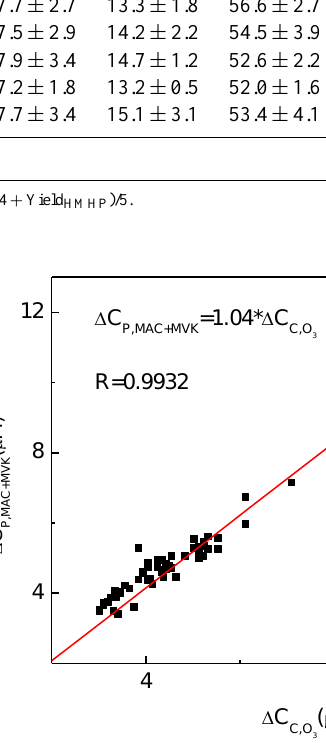
metric O 3 : isoprene ratio of